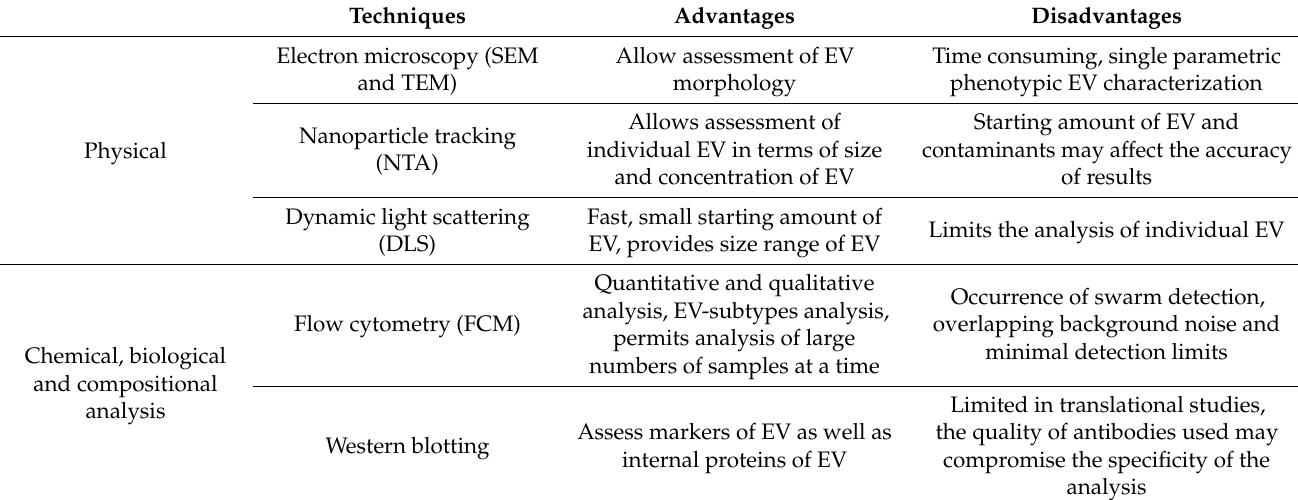
Table 2. Different techniques for EV